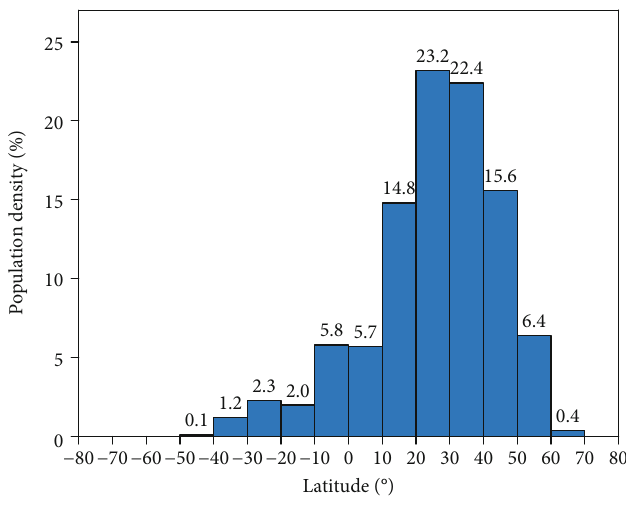
Table 1: Typical constellation con fi guration distribution table. Constellation